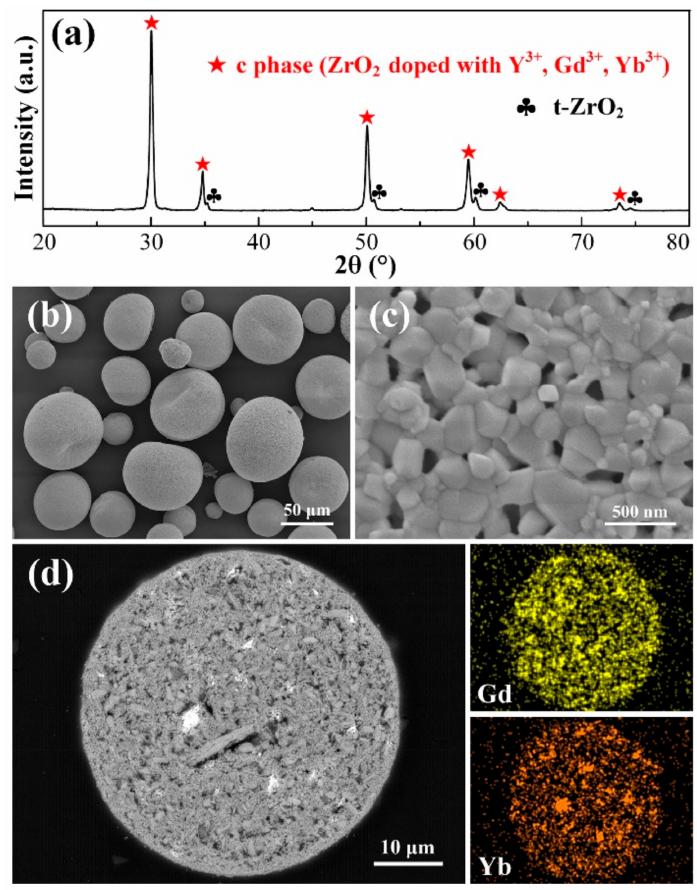
Figure 5. XRD pattern ( a ), surface morphologies ( b , c ), cross-sectional microstructure ( d ) and corre- sponding EDS Gd and Yb mapping results of 10YGYZ agglomerated powders calcined at 1200 ◦ C for 3 h. ( c ) is the enlarged SEM surface image of a single